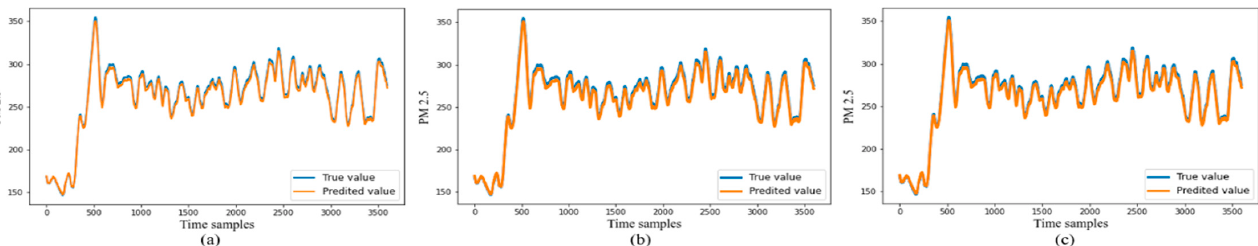
Figure 6. Figure of loss function in 1 h ahead prediction for ( a ) 20 epochs, ( b ) 30 epochs, ( c ) 40 epochs.